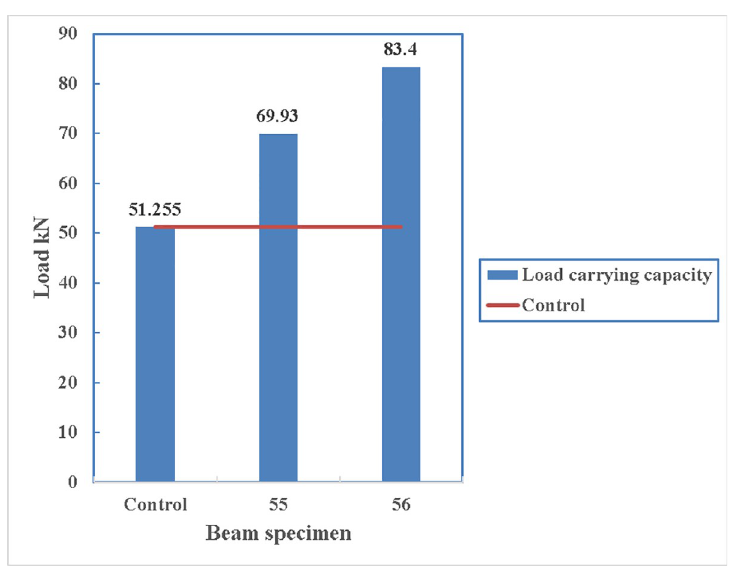
Fig 26. Load carrying capacity of beam 55 and beam 56.